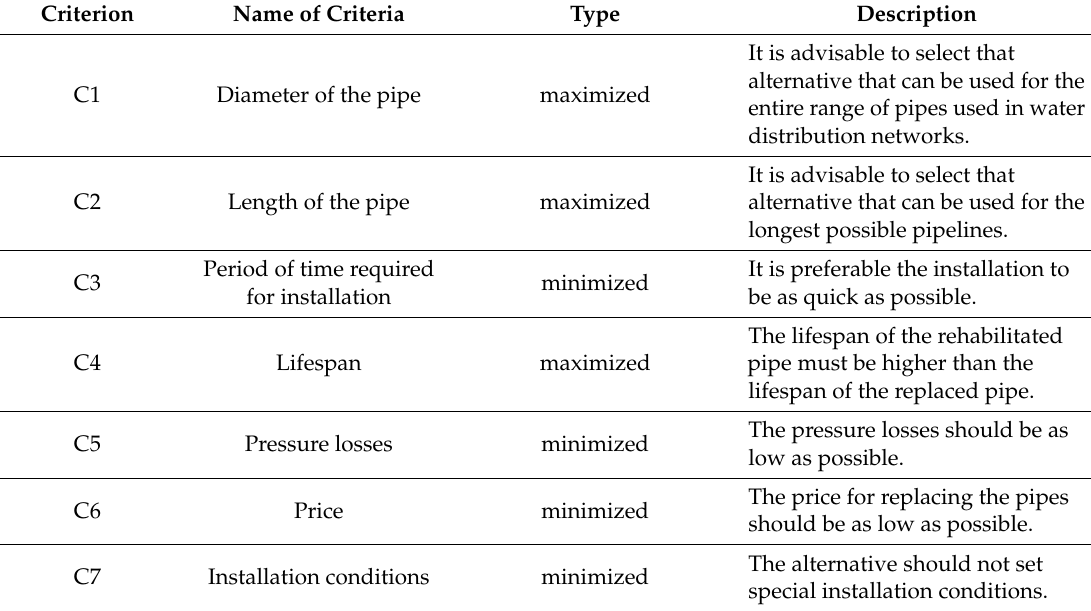
Table 4. The set of decision criteria